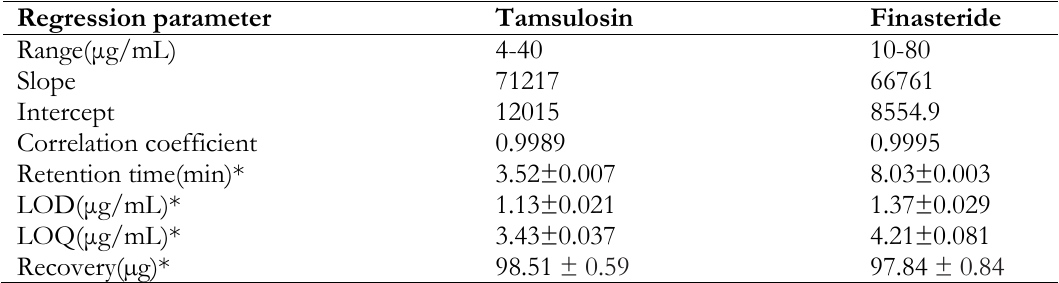
Table I. Analytical parameters of Tamsulosin and Finasteride Regression parameter